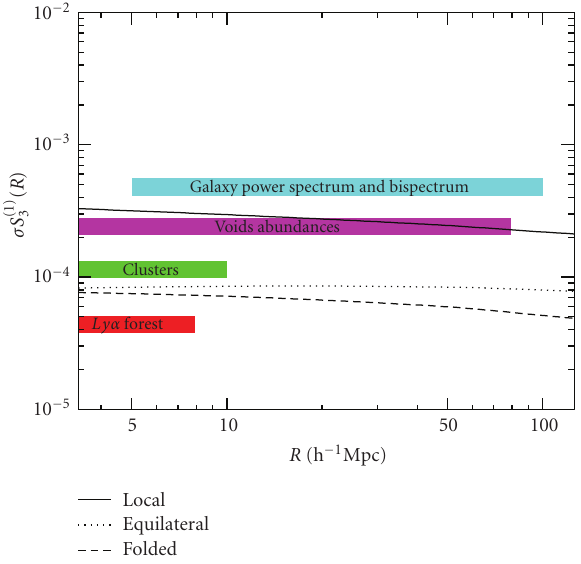
Figure 1: Skewness σS (1) 3 ( R ) of the smoothed density field in unit for the local, equilateral, and folded bispectrum shapes. The of f X NL skewness for the equilateral and folded templates is a factor of ∼ 3 smaller than in the local model. In any case, this implies that | σ | (cid:2) 1 on the scales probed by the large-scale structure R S 3 ( R ) for realistic values of the nonlinear coupling parameter, | f X 100. The shaded regions approximately indicate the range of scales probed by various LSS tracers. For the galaxy power spectrum and bispectrum, the upper limit sensitively depends upon the surveyed